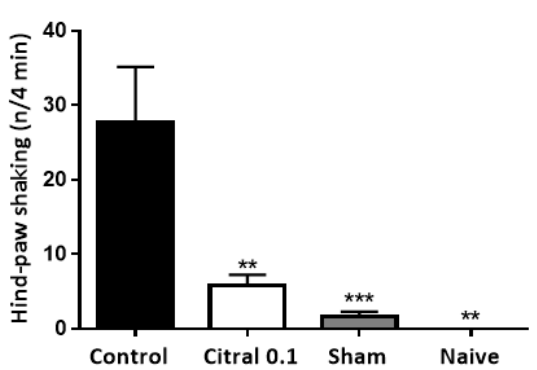
Figure 5: Effect of citral (0.1 mg/Kg) in craniofa- cial nociception model reflected in mustard oil- induced hind-paw shaking in rats. Each column represents the mean ± S.E.M (n=6/group). Num- bers above the bars indicate the percentage of analgesia. One-way ANOVA with post-hoc Tuk- ey’s test (**p<0.01; ***p 0.001 vs control). Mus- tard oil (20 %) was injected into the left masseter of animals 60 minutes after citral or vehicle (con- trol) administration. Citral and vehicle (control) were administered by gavage.